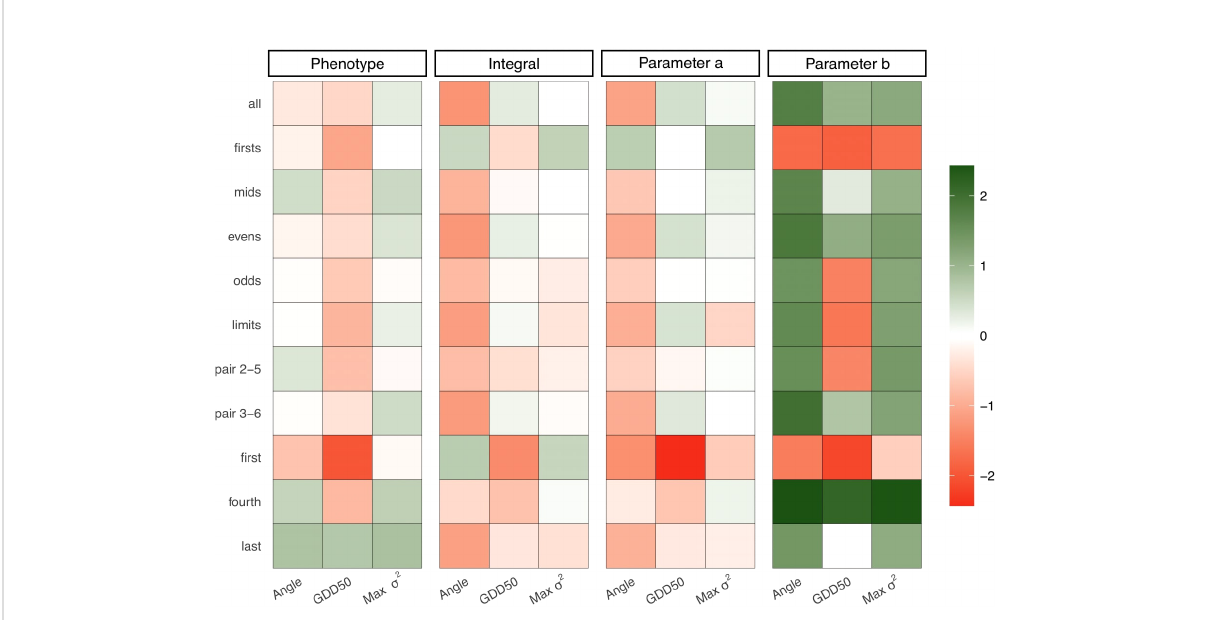
FIGURE 5 Relative performance of alternative metrics to AUDPC. Each grid represents the percentage of AUC gain of a scoring metric (x-axis) in a determined scenario (y-axis) and parameter (subplot title). Color scale has been normalized to avoid outliers impact on small values (AUC gains range from -86% to